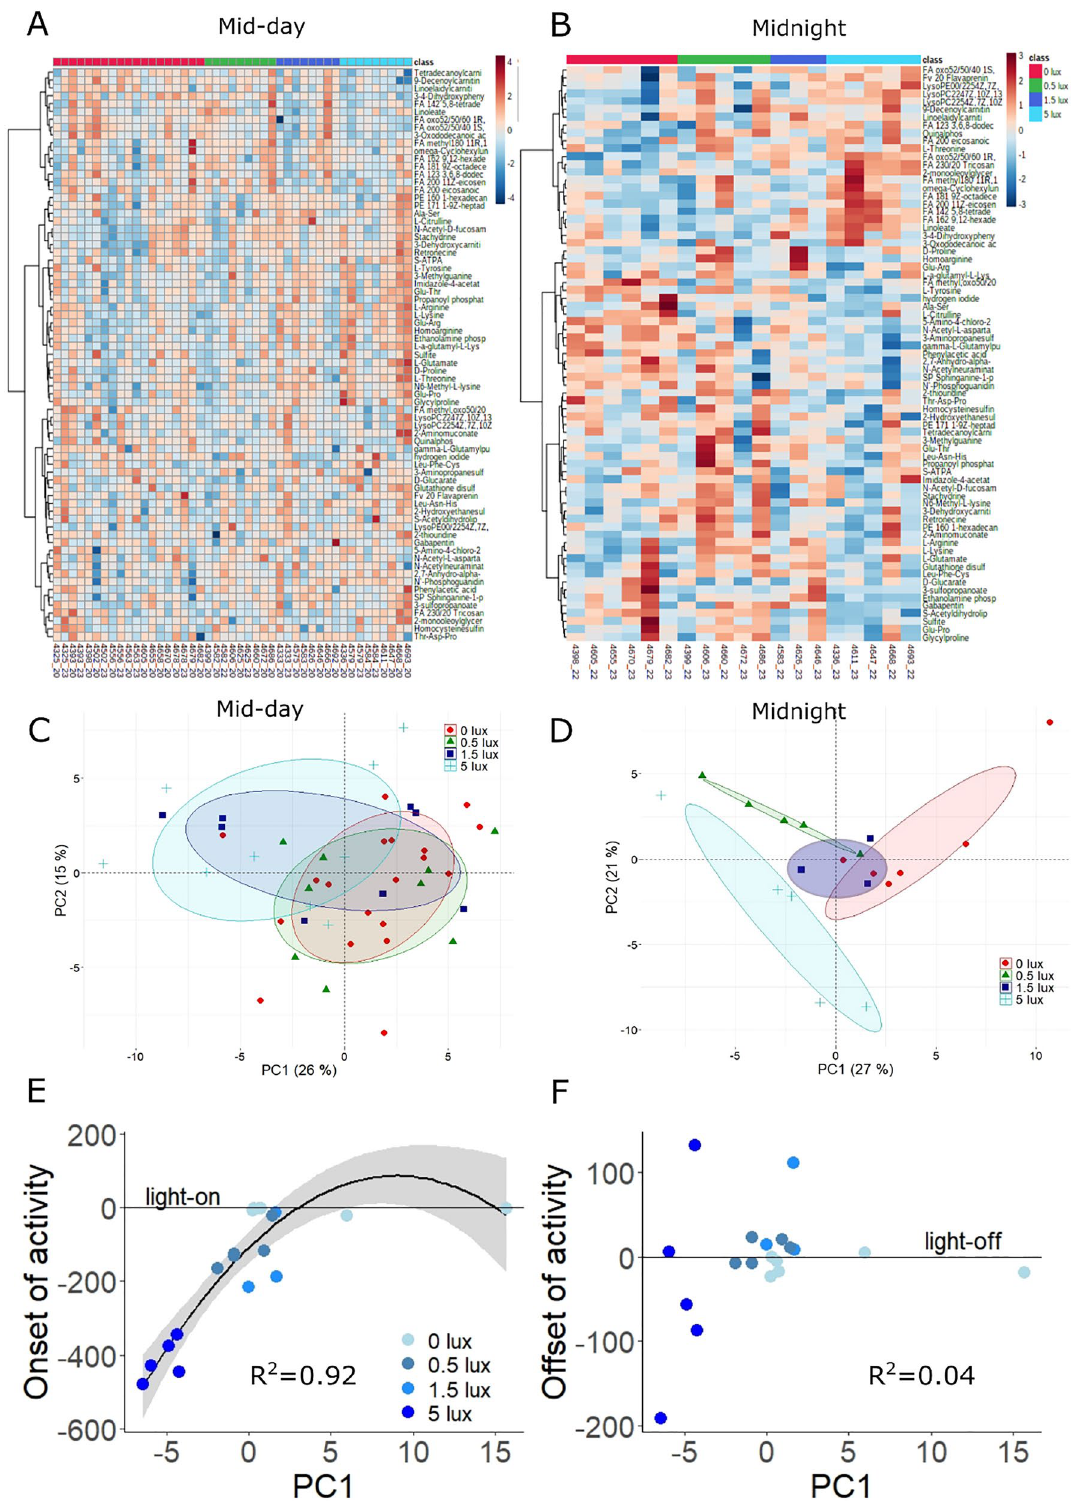
Figure 6. Metabolomics analysis supports ALAN-induced shifts in day–night physiology. The 73 metabolites found to be significantly affected by the interaction of treatment and sampling time (interactive dataset) were dissected by pathway analysis and PCA. Heatmaps show the top-25 metabolites at either mid-day ( A ) or mid-night ( B ). Heatmaps were created using the Metaboanalyst software 27 . PCA showed considerable overlap between ALAN groups at mid-day ( C ), whereas at midnight, ALAN treatment effects were pronounced, particularly for the 5 lux group ( D ). In all PCA plots, points represent individual samples, and ellipses contain 80% of samples in a group. The first PC of the night cluster significantly predicted the onset of activity ( E ), but not the offset of activity in the evening ( F ). In ( E ) and ( F ) points represent individual birds, and lines and shaded areas represent model fits ± 95% confidence